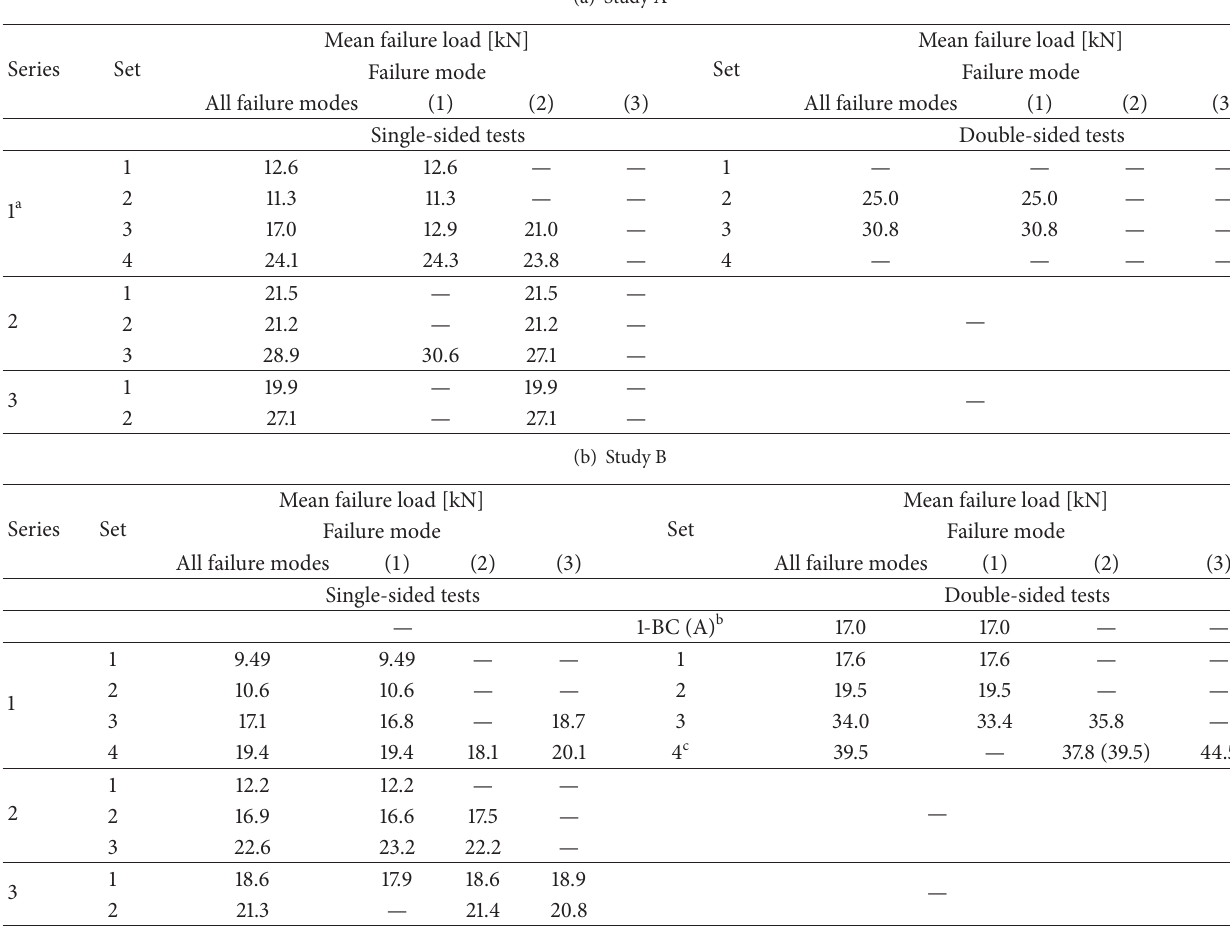
Table 2: Results from testing of specimens with the pith oriented upwards (PU). Failure modes are defined in Figure